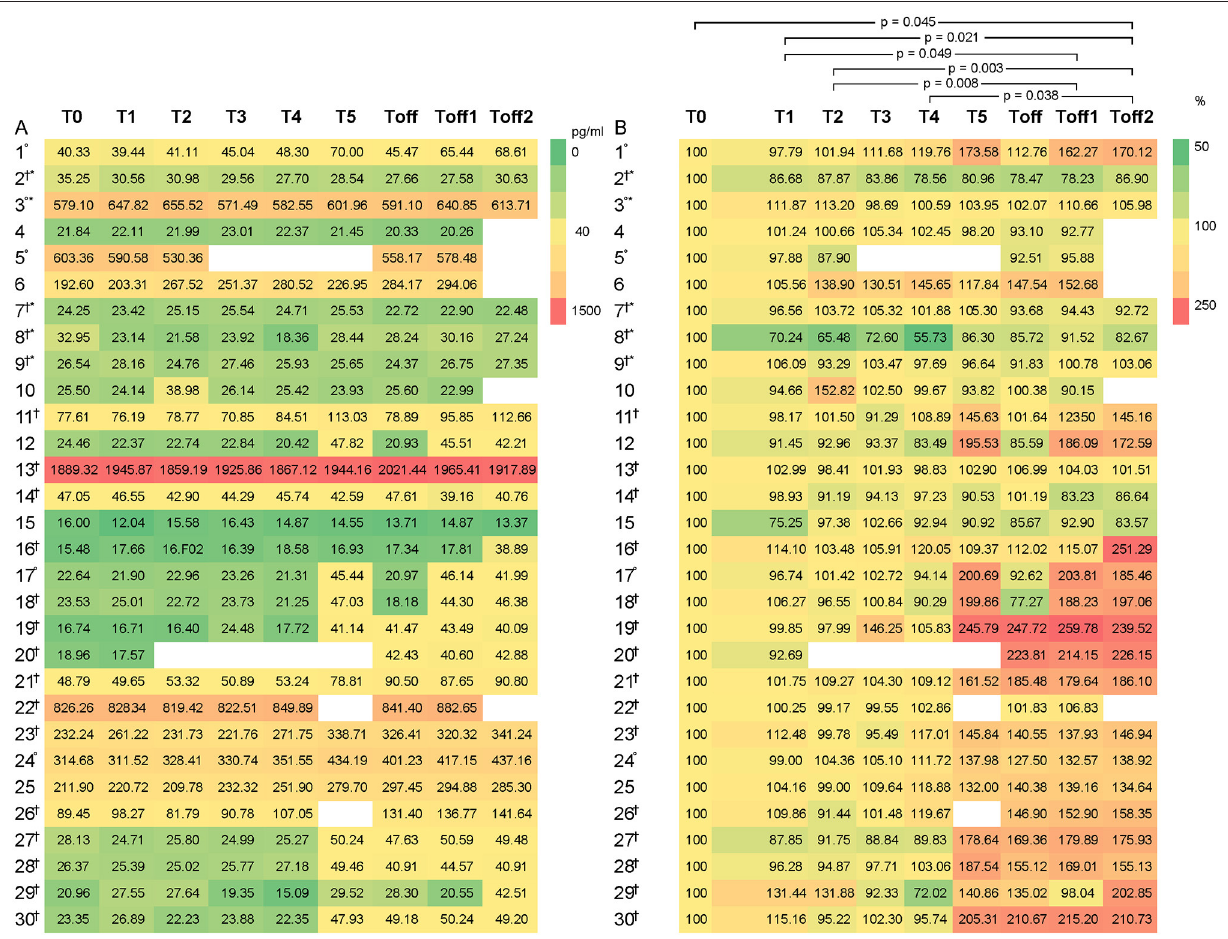
Frontiers in Neurology |